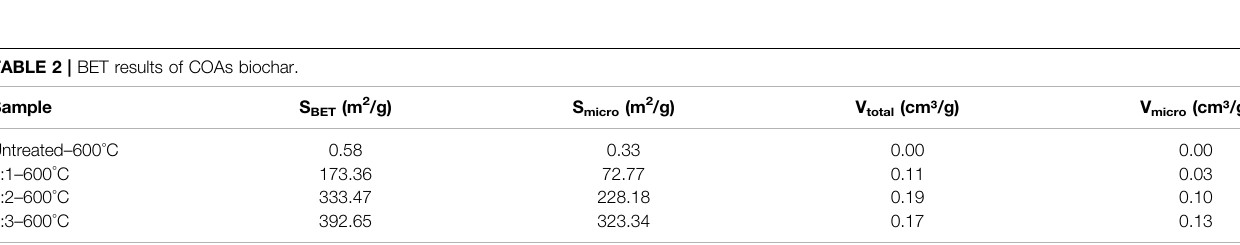
TABLE 2 | BET results of COAs biochar.